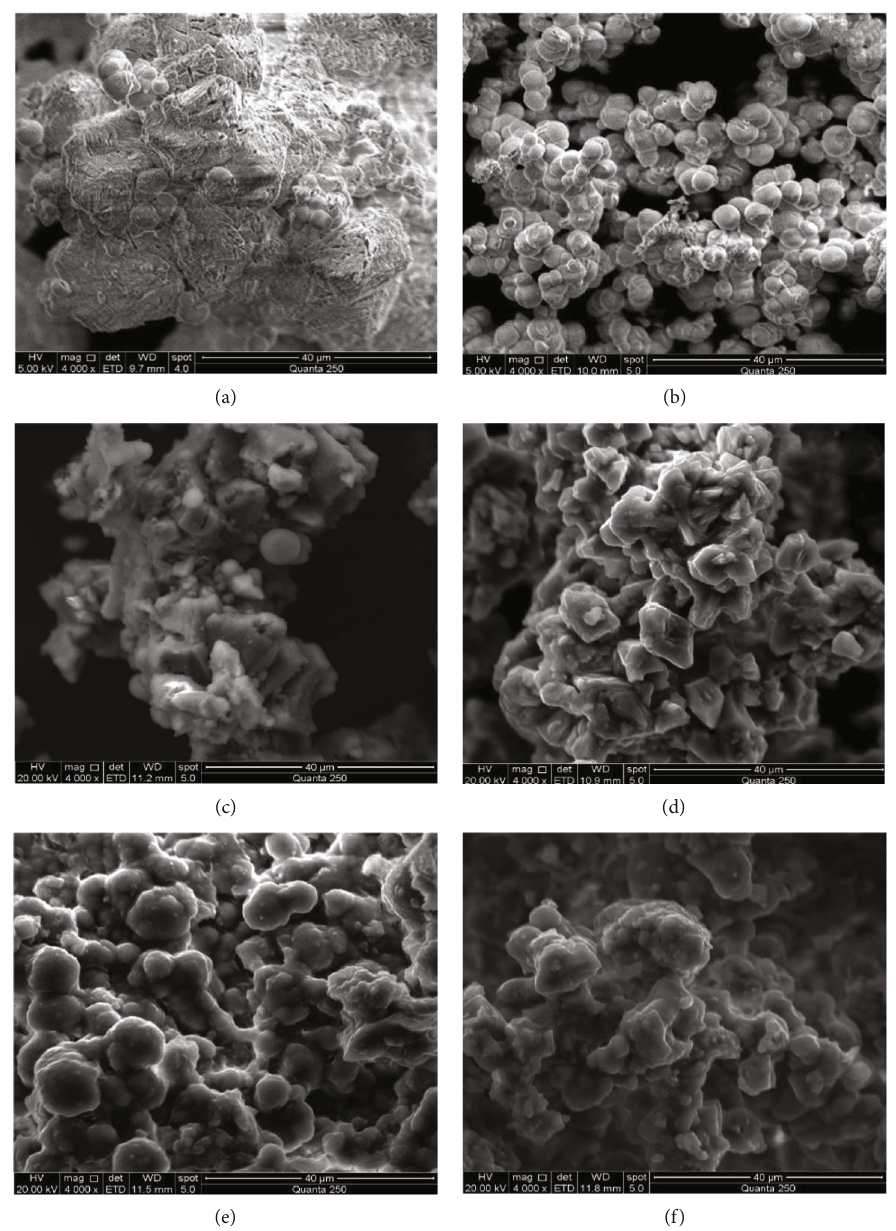
Figure 9: SEM images of cements of each experimental group (magni fi cation: 4000), reaction concentration: blank group (a); (b) BSA with mass fraction of 0.3%; (c) sucrose with a mass fraction of 5%; (d) bamboo leaves with a mass concentration of 25 g/L; (e) the mass fraction of bamboo leaves is 25g/L + 2mol/L MgCl ; (f) 20% egg white protein by 2